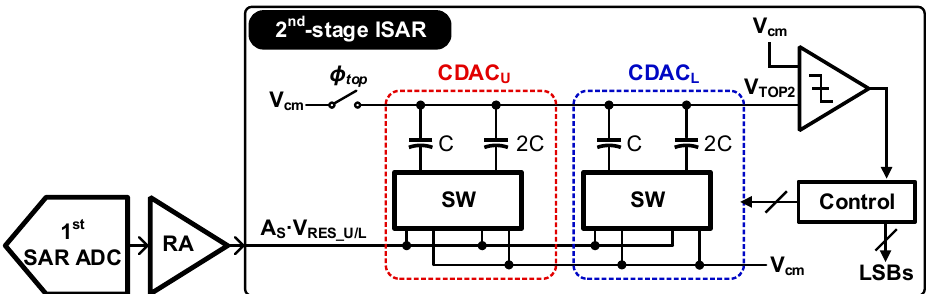
Figure 9. Schematic of the proposed interpolation SAR ADC.